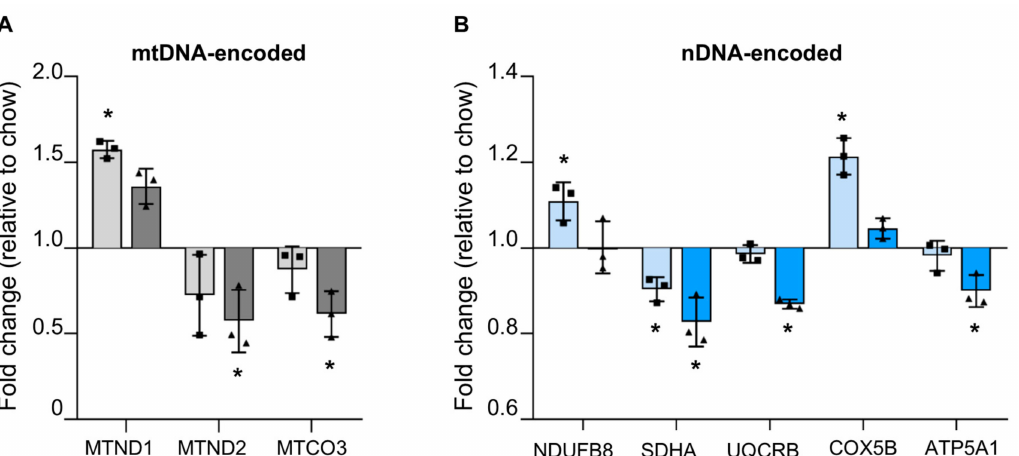
Figure 4. Altered levels of oxidative phosphorylation (OXPHOS) subunits in steatotic liver. The levels of several ( A ) mtDNA-encoded and ( B ) nDNA-encoded OXPHOS subunits are seen to be significantly altered in steatotic livers of mice fed with high fat (light grey / light blue) or Western (dark grey / dark blue) diets. Fold-changes are shown relative to levels in chow-fed mice. Bars indicate mean ± standard deviation for n = 3 mice. * p < 0.05 as determined by unpaired student t-test versus chow